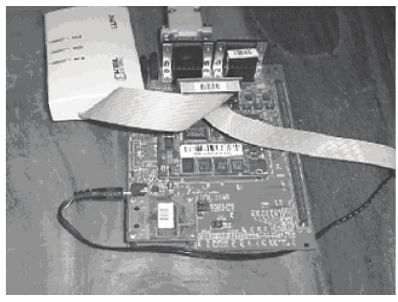
Figure 6: The ATMEL (AT91M55800A)-embedded microcon- troller target board.